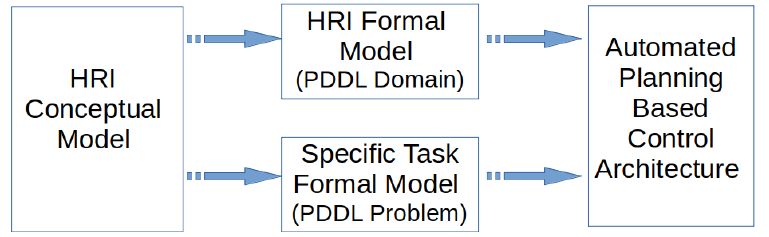
Figure 1. Formal models of HRI for a control architecture based on